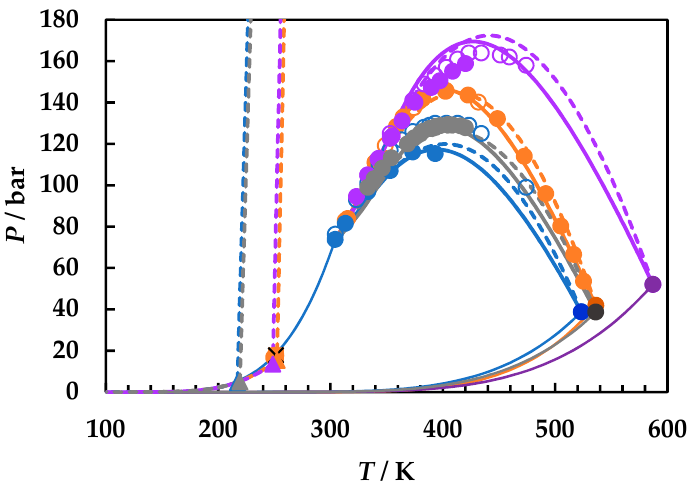
Figure 1. P – T fluid phase diagrams for carbon dioxide (1) + ethyl acetate (2), + 1,2-dimethoxyethane (2), + 2-butanol (2), and + 1,4-dioxane (2) binary systems. Symbols, literature data [22,45,50–53]; full lines, predictions by GEOS; dotted lines, predictions by Peng–Robinson (PR) equation of state (EoS). CO 2 + ethyl acetate ( blue ); CO 2 + 1,2-dimethoxyethane ( gray ); CO 2 + 2-butanol ( orange ); CO 2 + 1,4-dioxane ( purple ).